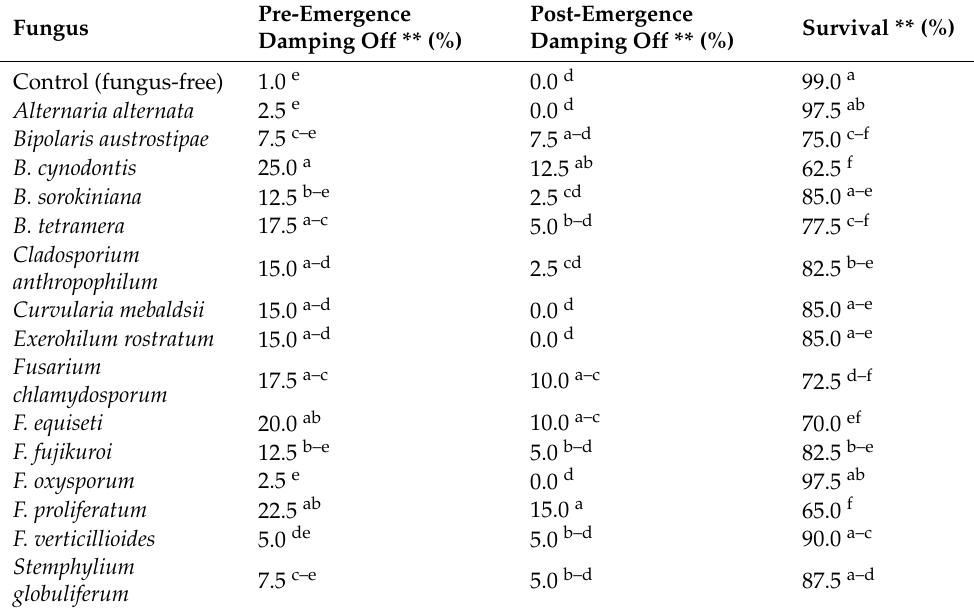
Table 3. Pathogenicity of 15 seed-borne fungus species isolated